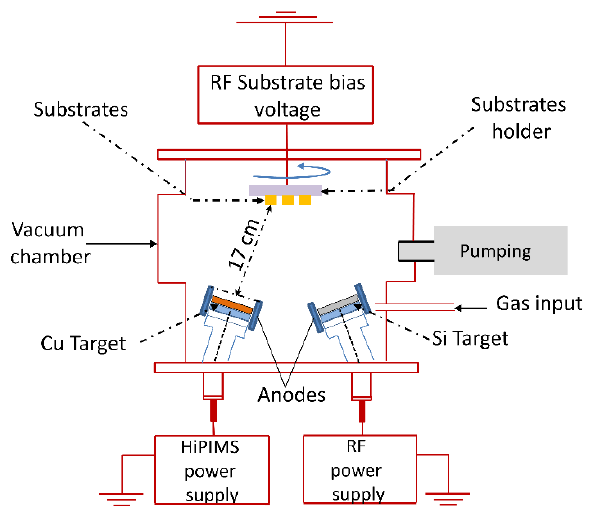
Figure 1. Experimental setup for mono- and multilayer deposition.